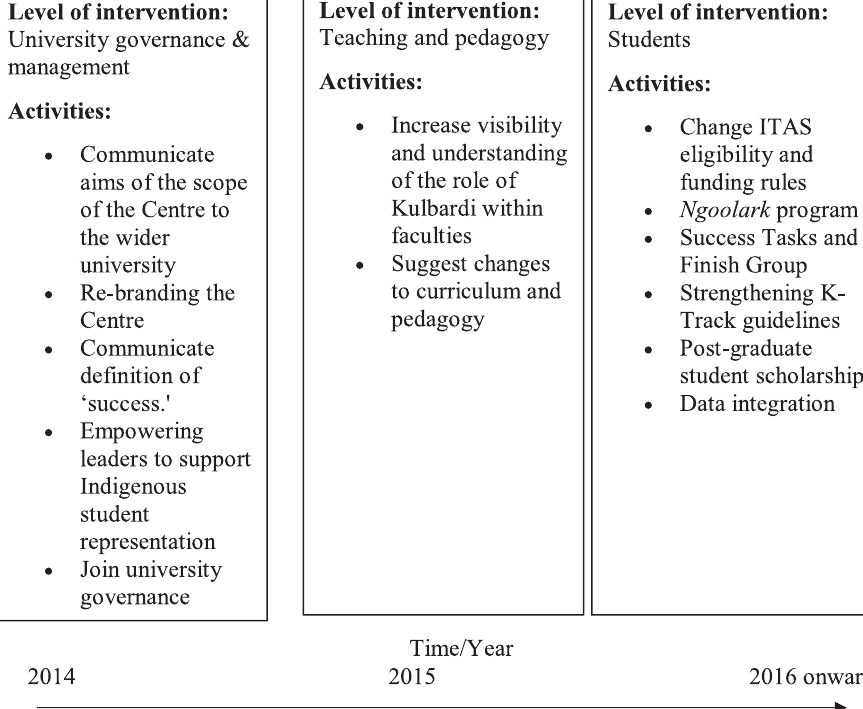
Implementation plan for Kulbardi ‘ s Student Success